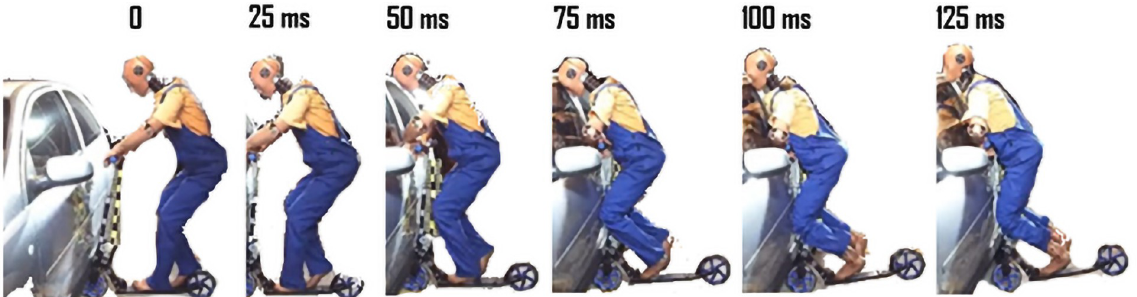
Fig 2. Scooter-to-B-pillar impact—Physical experiment depicted in 25 ms intervals; authors’ illustration based on published fka company materials [18].